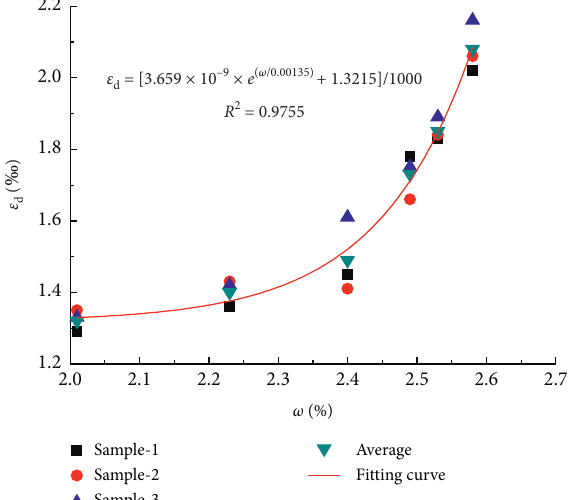
Figure 10: Dependence of peak strain on moisture